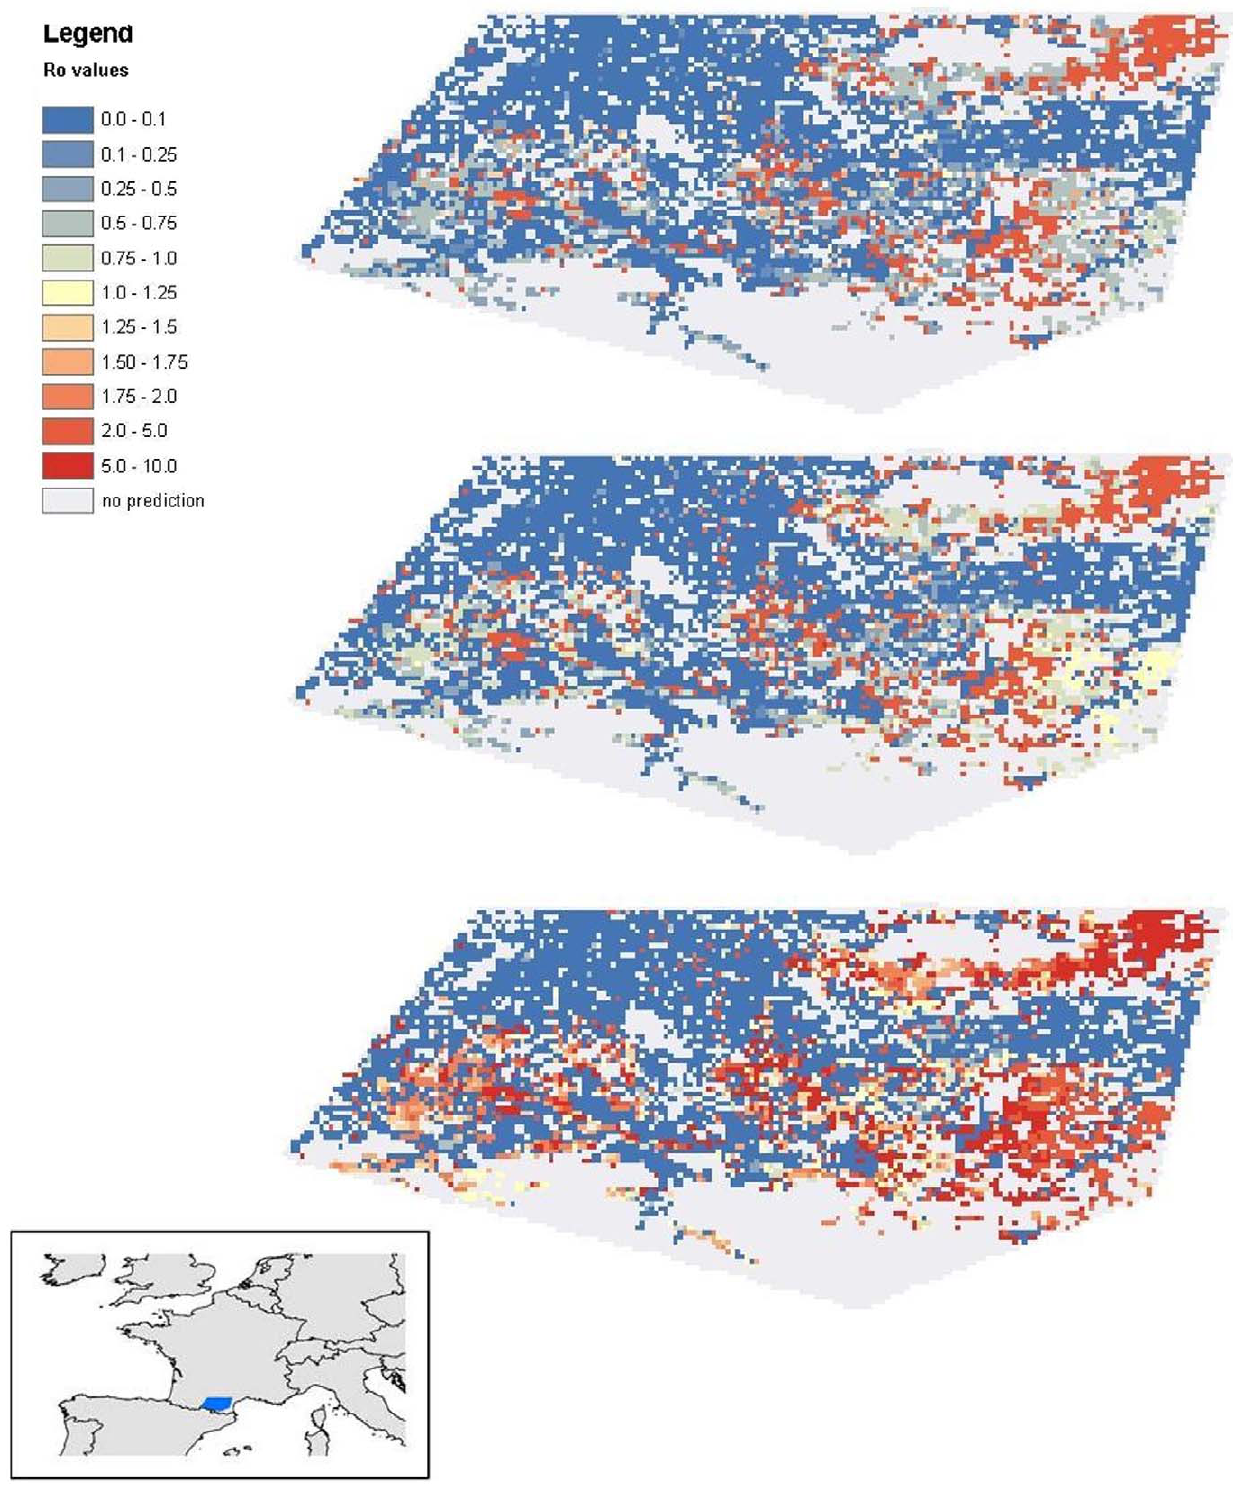
Figure 5. R 0 maps based on the predicted vector abundance maps, the dog density map, and the parameter point estimates in Table 1. R 0 maps are depicted for different values of the multiplication factor: f=500 (a), f=1000 (b), and f=5000 (c). Resolution is 1 km 2 .